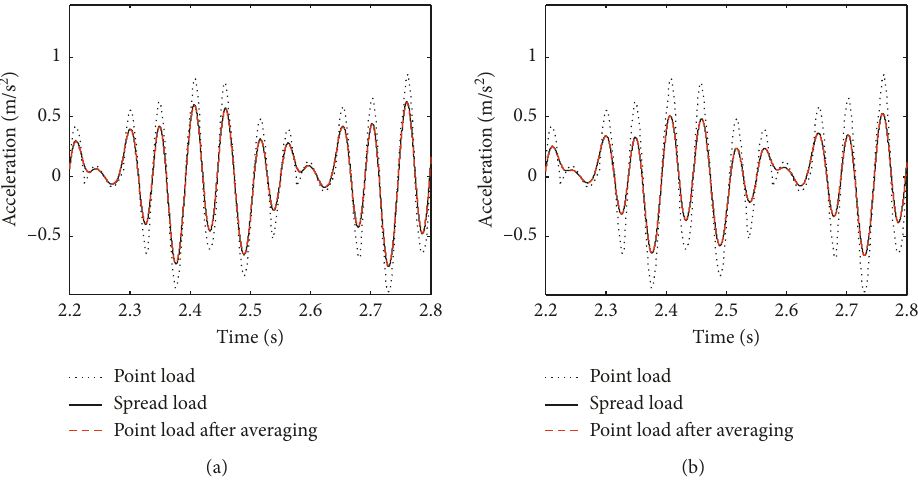
Figure 8: Bridge acceleration time history at nonresonance speed (ML model). (a) EC block load. (b) Triangular